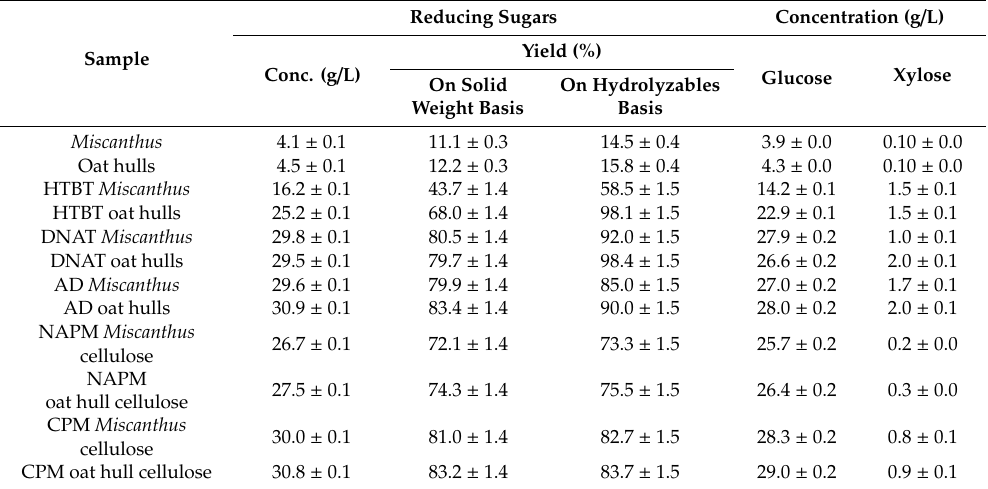
Table 2. Characteristics of hydrolyzates obtained after 72 h of enzymatic hydrolysis (acetate bu ff er).